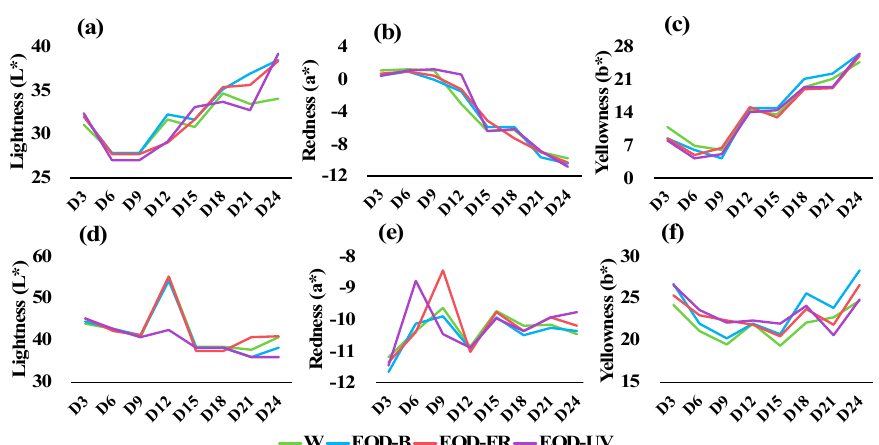
Figure 5. Leaf color transformation of lettuce 3 to 24 days after treatments. ( a – c ) were color parameters of ‘Red butter’ lettuce. ( d – f ) were color parameters of ‘Green butter’ lettuce. W = day-white light, EOD-B = end-of-day enhanced blue light, EOD-FR = end-of-day far-red light, EOD-UV = end-of-day ultraviolet-A light.